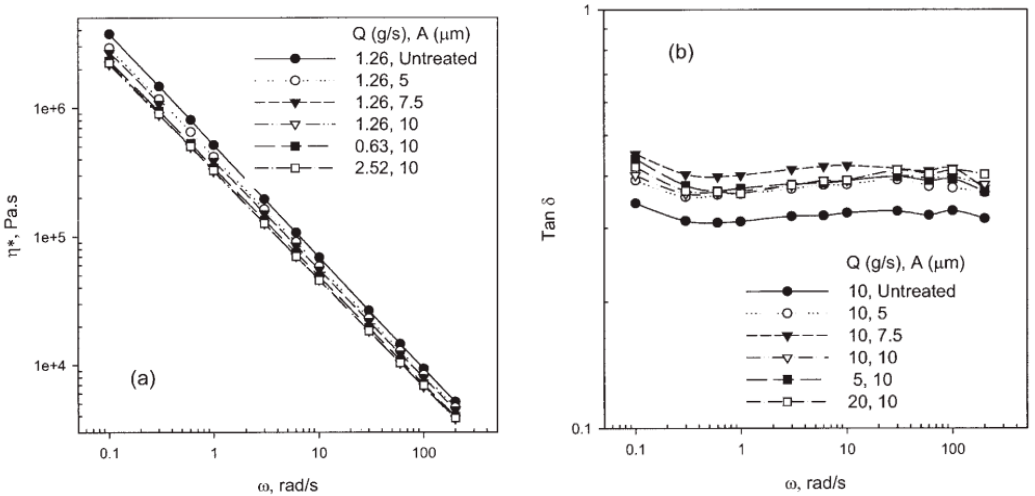
Figure 14. ( a ) Complex dynamic viscosity and ( b ) loss tangent as a function of frequency for untreated and regenerated rubber obtained at various amplitudes and flow rates (reproduced with permission from [65]).